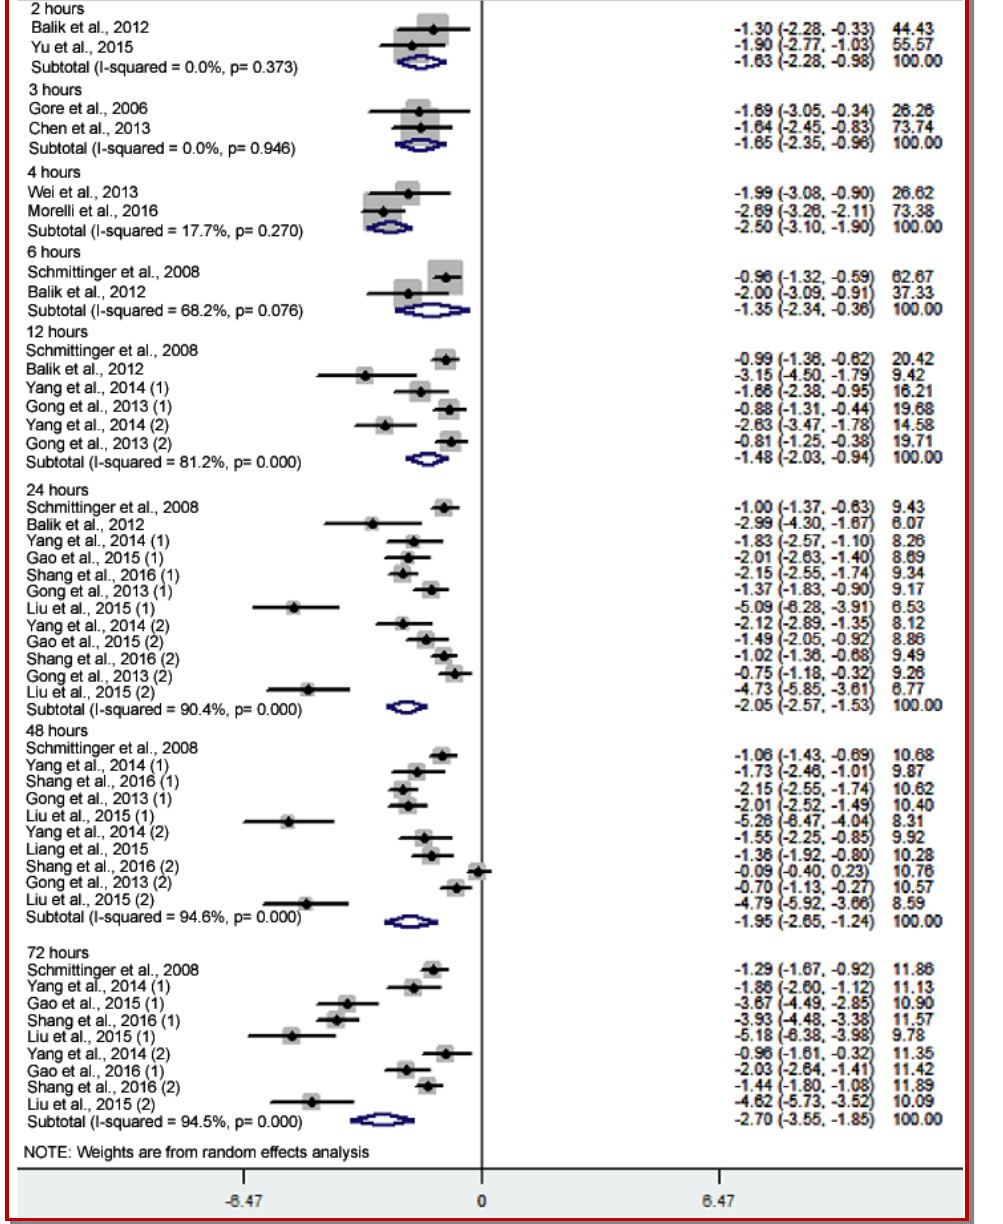
Figure 3: Meta-analysis of beta-blocker on the heart rate (digit within the parenthesis means the number of studies for compari-